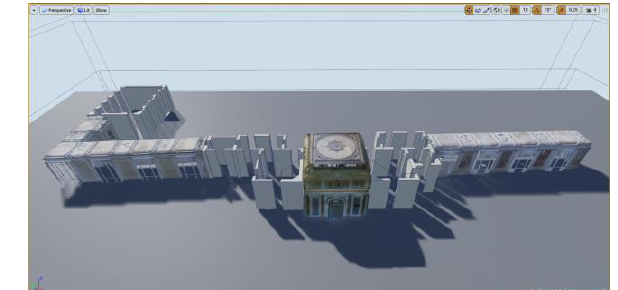
Figure 7. Overhead projection of the palace ground floor, where only three chambers were modelled with textured meshes (Both Galleries and Big Hall). Other chambers were placed in 3D as extrusion of walls